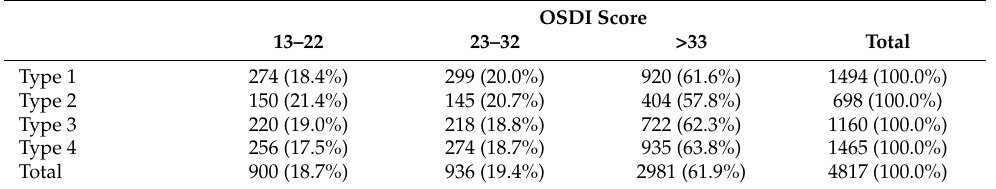
Numbers in parentheses represent percentages within the OSDI range of the indicated dry eye subtype. Chi-square p =